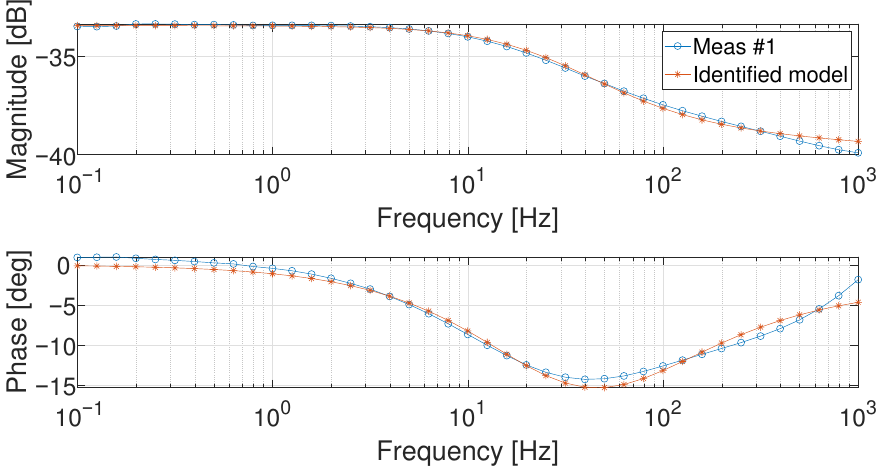
Figure 10. Bode diagrams of the identified Meas #1 at